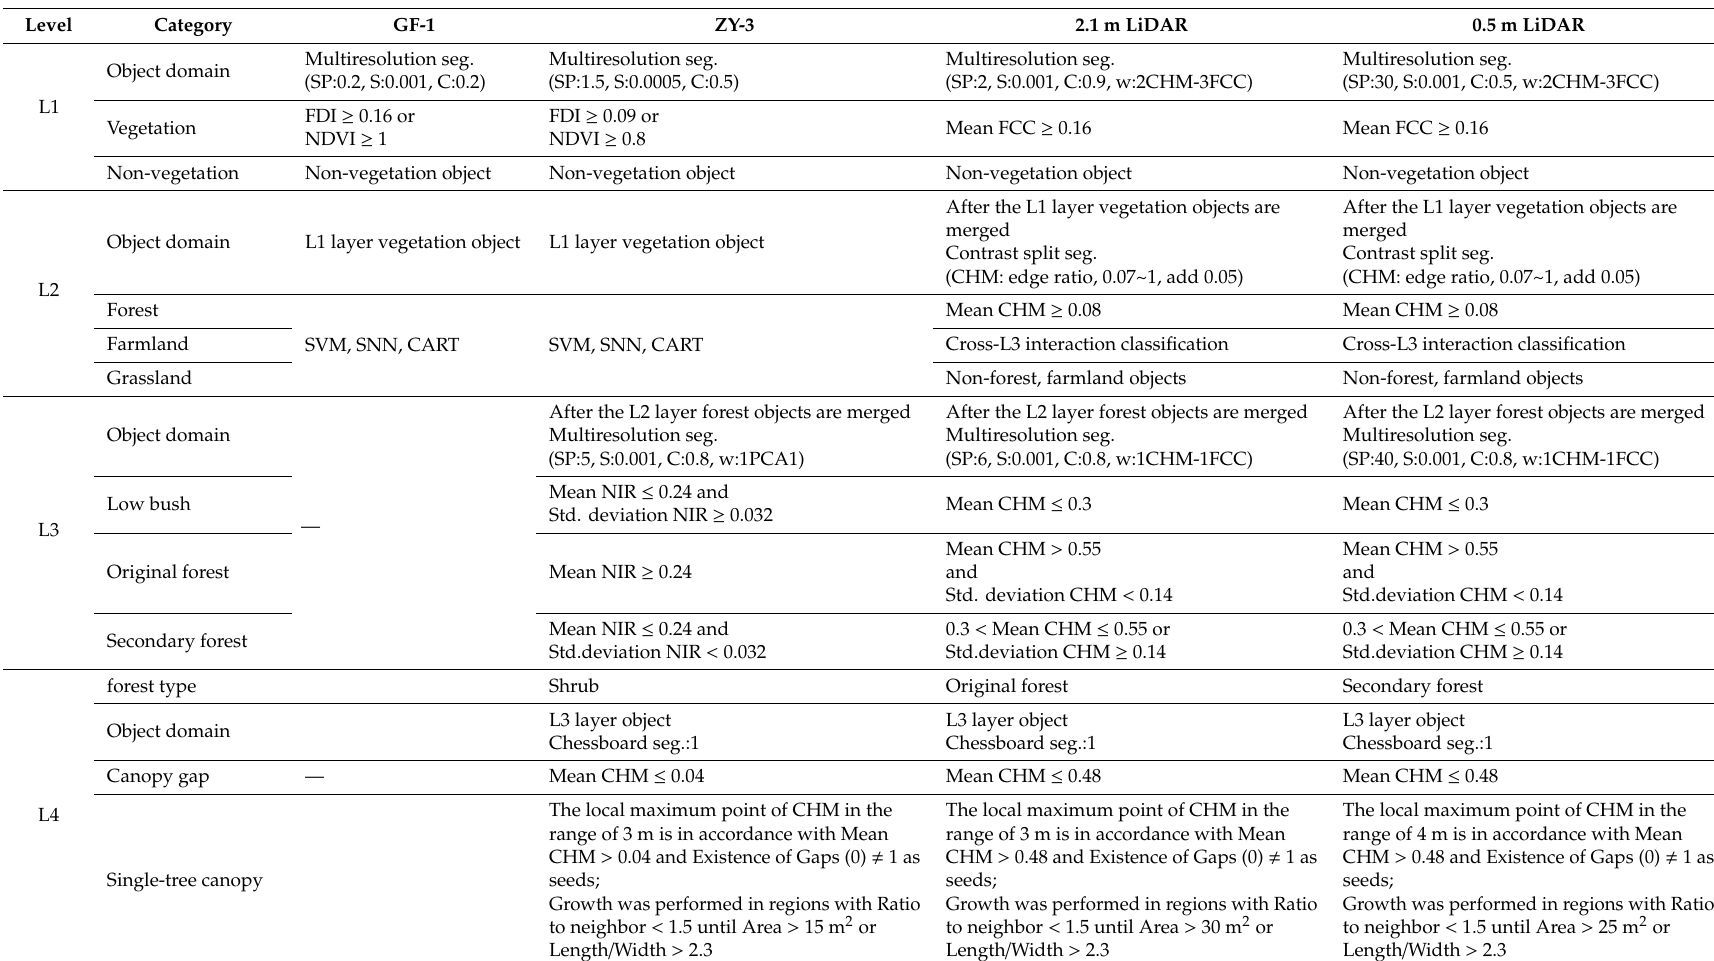
Table 2. Four layers of image object processing and classification rule